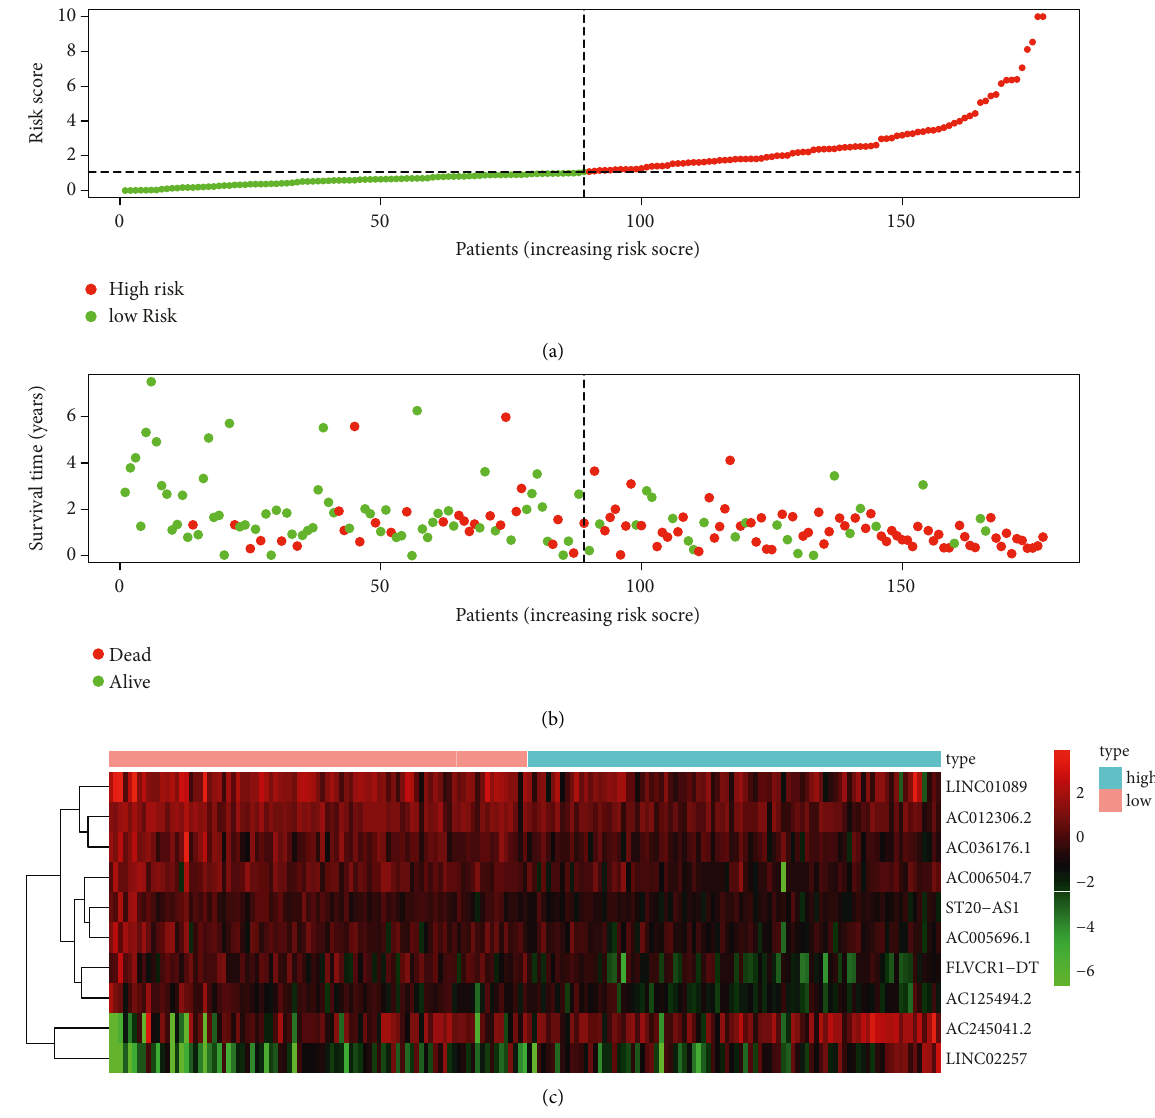
Figure 5: Risk score evaluation of a prognostic, autophagy-related lncRNA model of PC. (a) Risk score of the risk model. (b) The scatter plot reflects the survival period of PC patients. (c) Heat map demonstrating 10 differentially expressed prognostic lncRNAs is